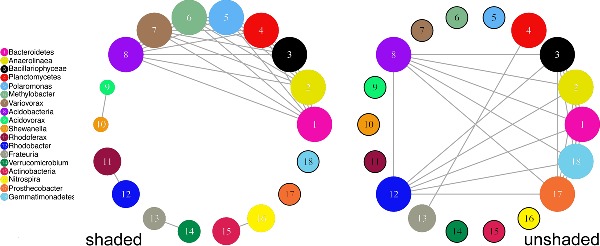
Riparian shading as a mitigation of harmful algal blooms leads to significant structural changes to both bacterial and algal communities in river biofilms.